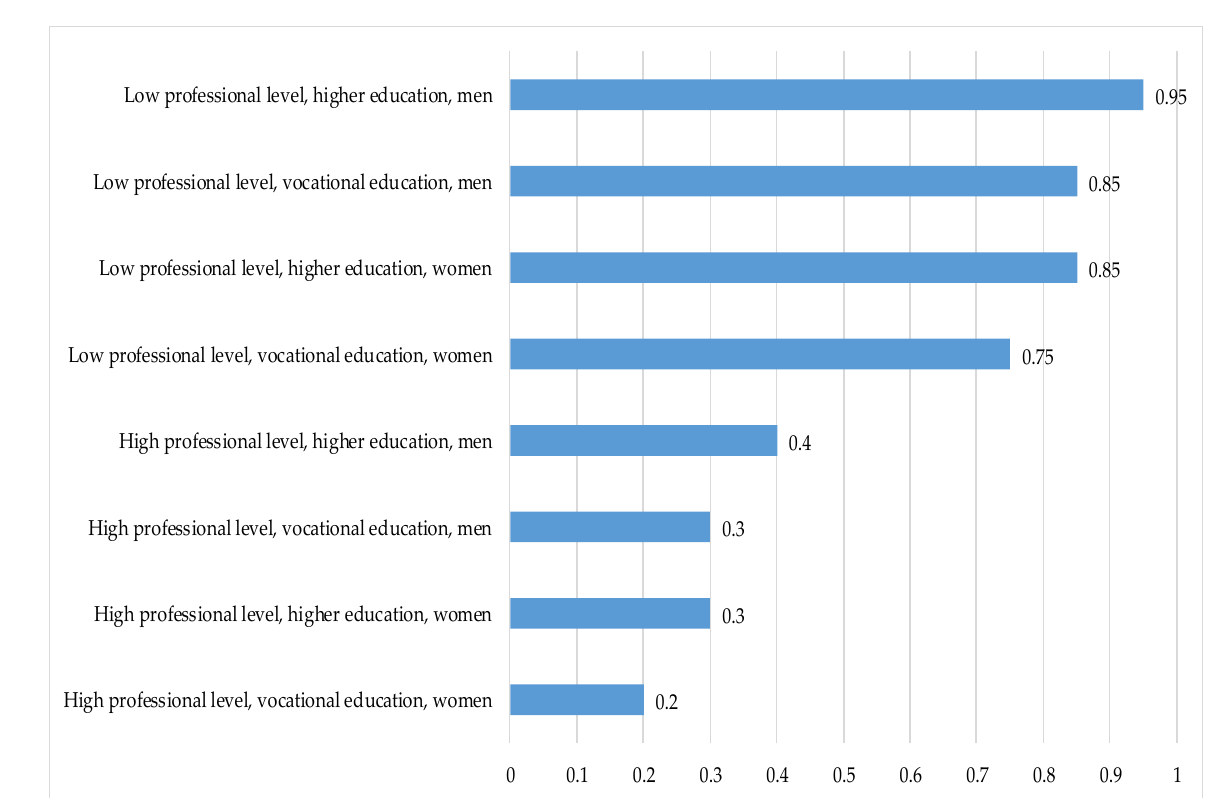
Table 1. Interpretation of model parameter values (author’s calculations).